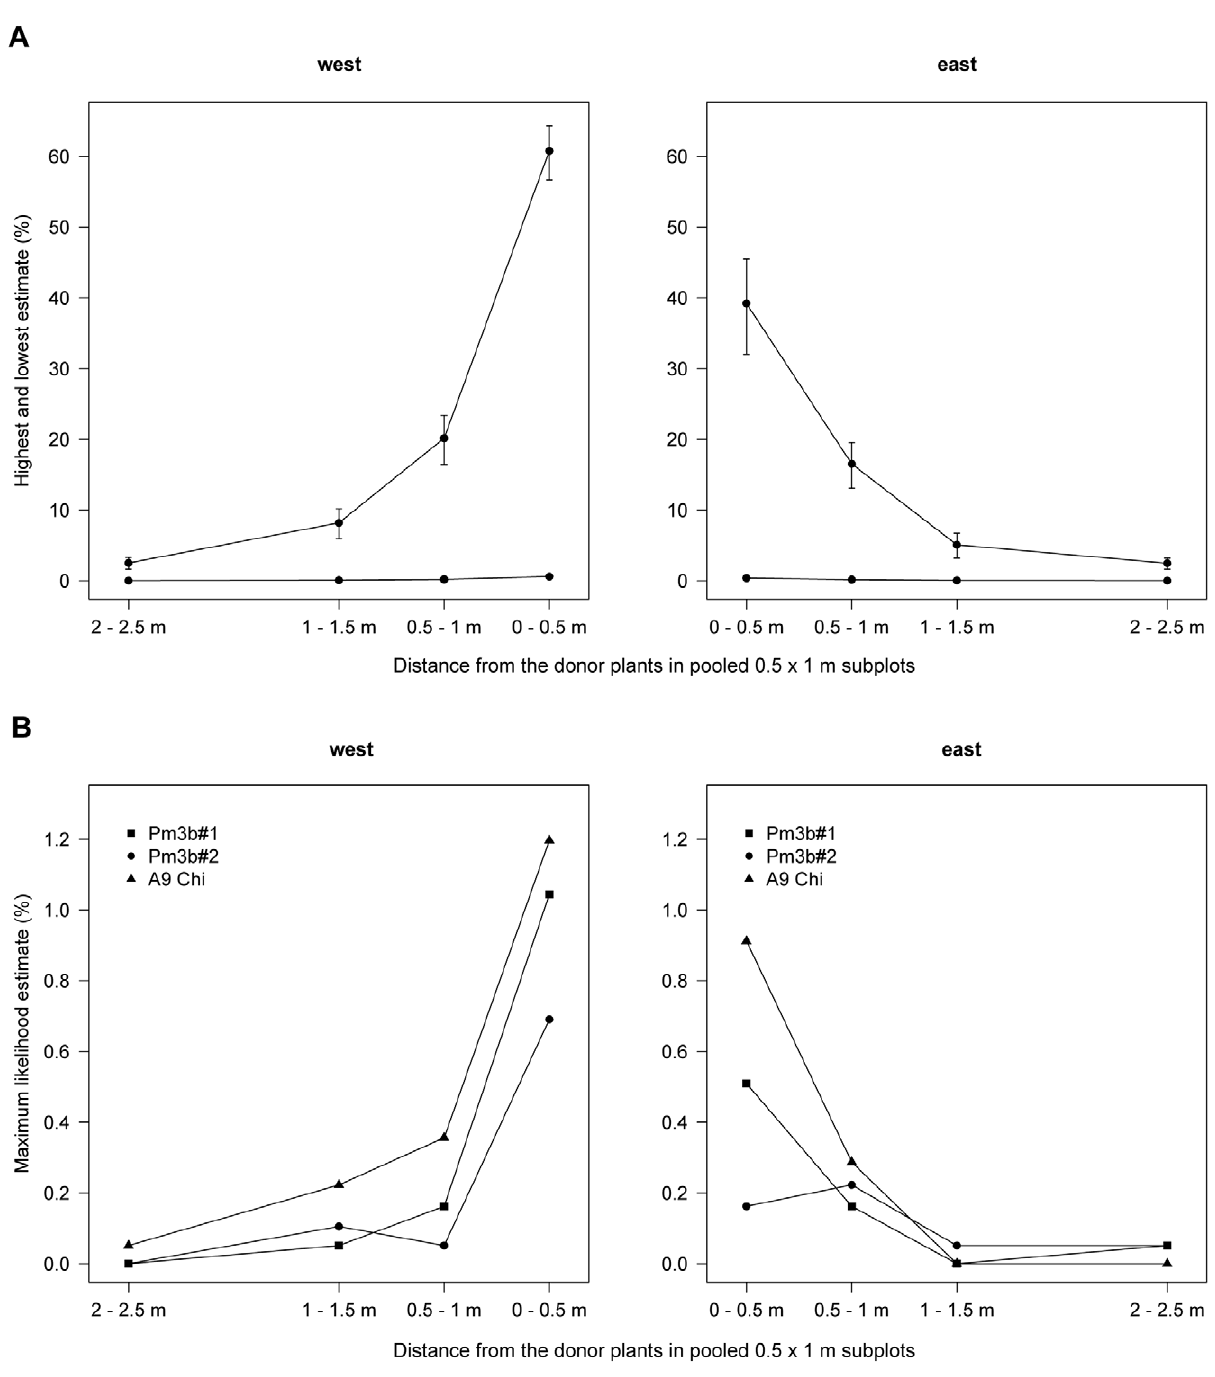
Figure 1. Cross-pollination of GM wheat over short distances and in two wind directions. A: Upper and lower boundaries of cross- pollination rate estimates (mean 6 1 SE, back-transformed from logit scale) for western and eastern distance subplots. Data from all lines were pooled. B: Maximum likelihood estimate of cross-pollination rate for the western and eastern subplots for the lines Pm3b # 1, Pm3b # 2 and A9 chi . These estimates indicate cross-pollination rates between 1.2% and 0.16% in the closest and 0.05% and 0.0% in the farthest subplots.